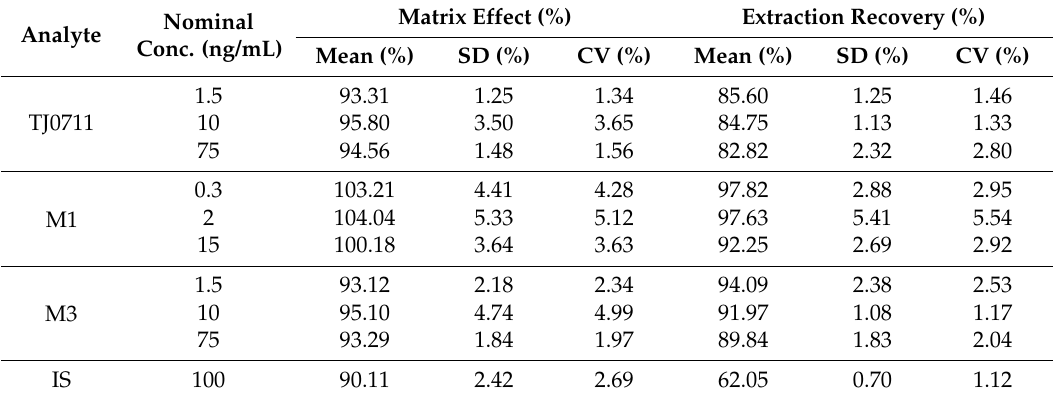
Table 3. The matrix effect and extraction recovery of TJ0711, M1, M3, and IS in dog plasma ( n = 6).